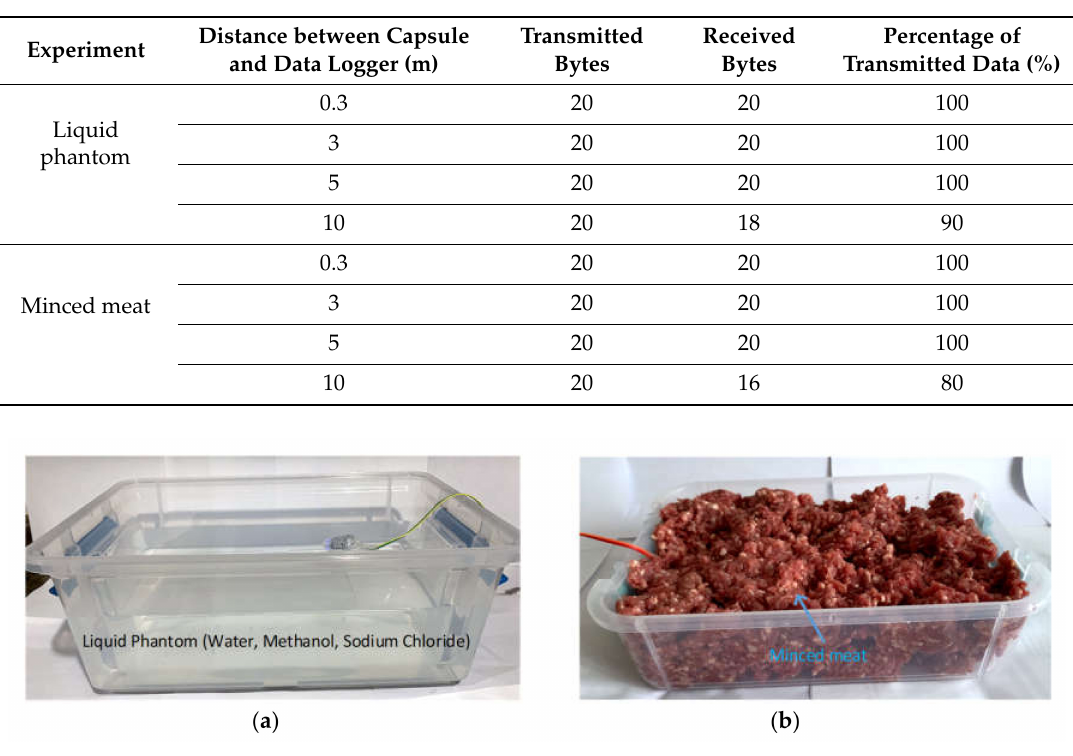
Table 3. Transmission performance of the capsule.